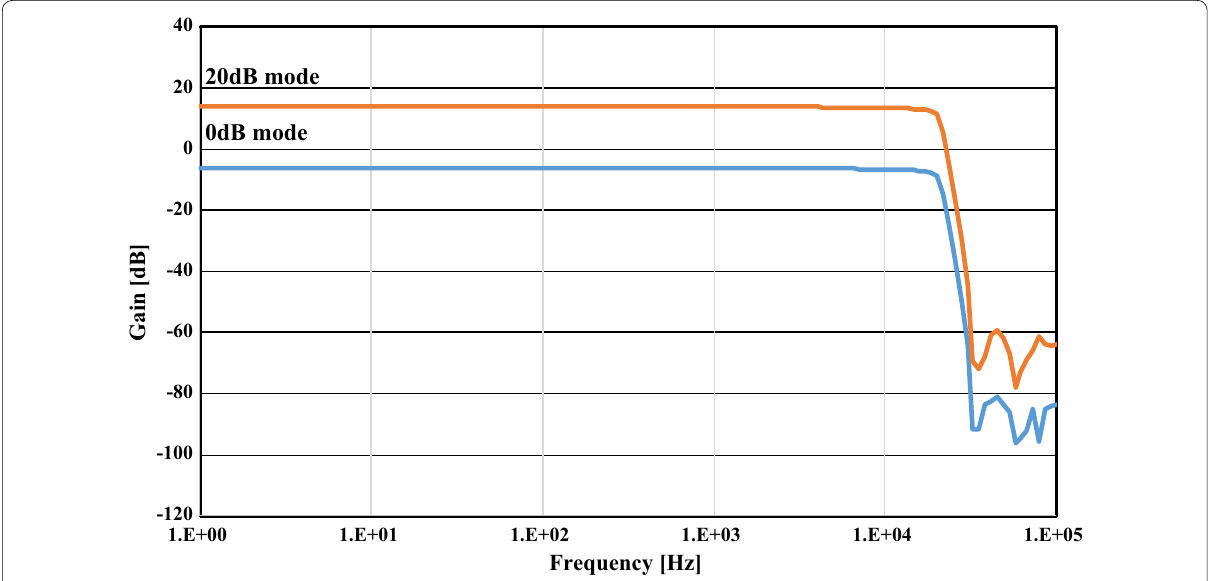
channels. The receivers consist of attenuators (0 or 10 dB), HPF, and LPF. The passband of the receiver is from 10 kHz to 10 MHz. The analog signals are sampled by an A/D converter in the HFA-D with a 25-MHz sam- pling rate. The spectra are obtained in two signal process- ing modes by field-programmable gate array (FPGA) in HFA-D. In the 10-MHz mode, a fast Fourier transform